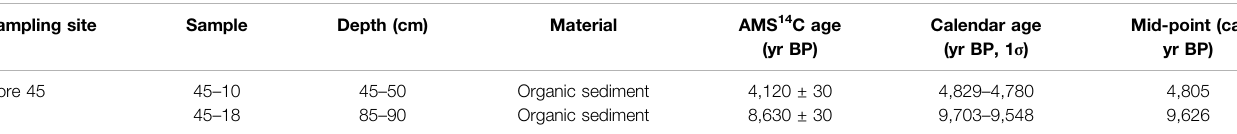
TABLE 2 | AMS 14 C ages dated on core 45.